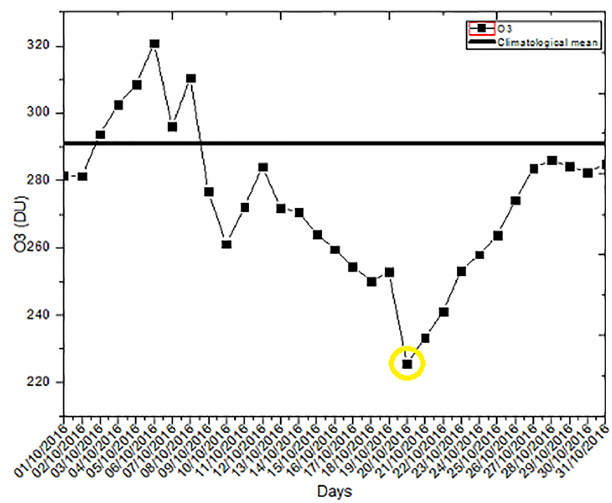
Figure 1. Daily mean of the total ozone column in October showing the reduction analyzed (yellow circle) and the climatological mean for the reference month (continuous black